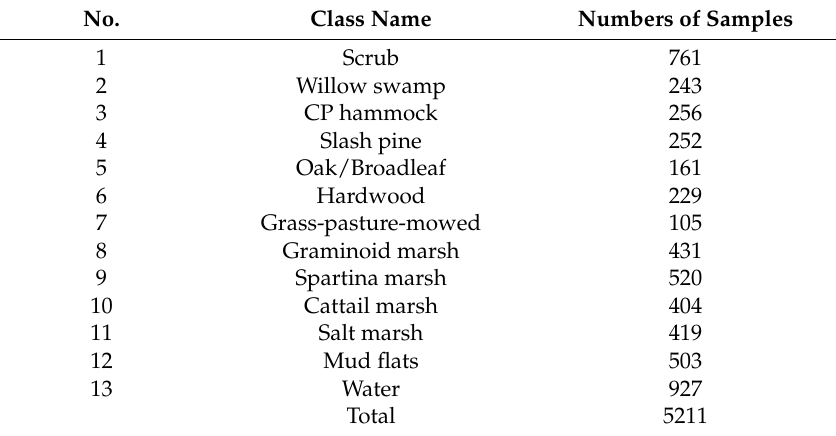
Table 3. Land cover classes and numbers of samples in the Kennedy Space Center (KSC) data set.